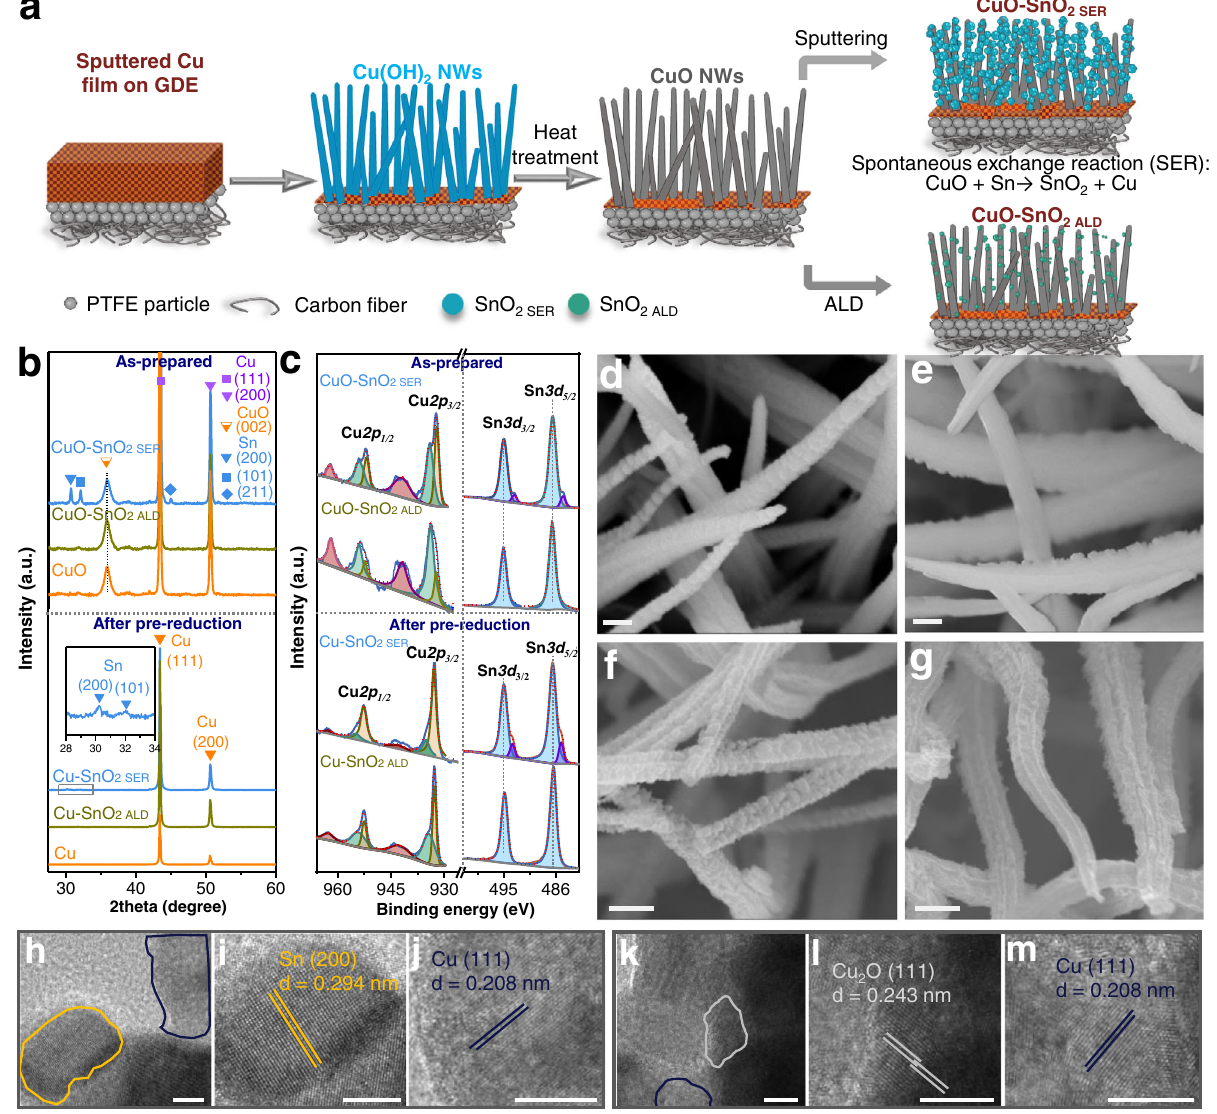
Fig. 1 | Structural and chemical characterizations of Cu-SnO 2 catalysts. a A schematic route for the synthesis of CuO-SnO 2 SER and CuO-SnO 2 ALD catalysts. b XRD and ( c ) XPS of as-prepared CuO, CuO-SnO 2 SER , CuO-SnO 2 ALD and the ones after pre-reduction at − 30mA cm − 2 for ~100s. SEM images of as-prepared ( d ) CuO-SnO 2 SER , ( e ) CuO-SnO 2 ALD samples and pre-reduced ( f ) Cu-SnO 2 SER , ( g ) Cu-SnO 2 ALD catalysts. h Representative HRTEM images of pre-reduced Cu-